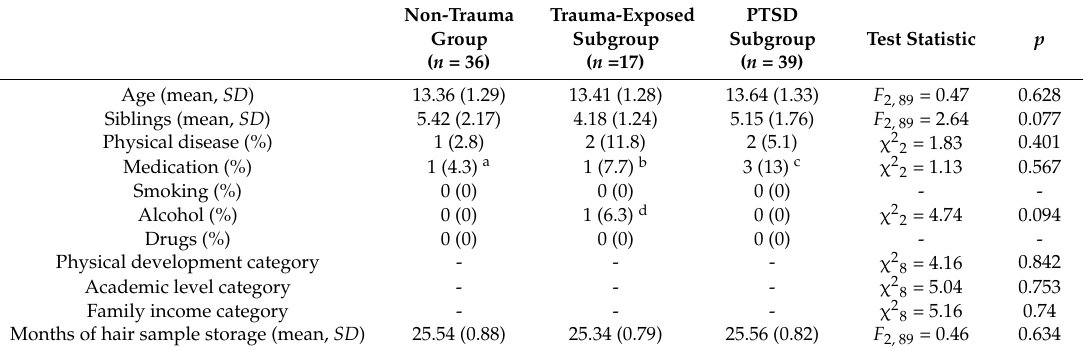
Table 1. Comparison of demographic and hair-related characteristics of study groups (non-trauma, trauma-exposed and PTSD participants) based on the UCLA PTSD Reaction Index for DSM IV, Child